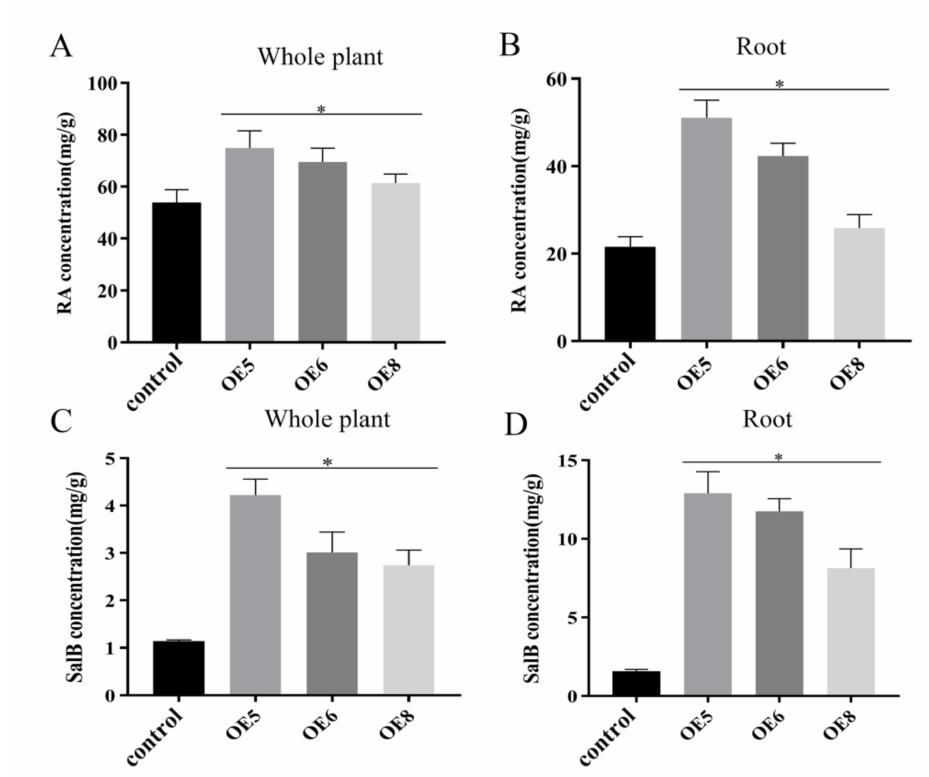
Figure 6. Concentrations of salvianolic acid B (SalB) in the whole plant ( C ) or the roots ( D ) and rosmarinic acid (RA) in the whole plant ( A ) or the roots ( B ) of the SmSPL6 -overexpressed (OE) transgenic lines and the control. All data are the means of three biological replicates, with error bars indicating SD; * represents a significant difference at p < 0.05 compared with the